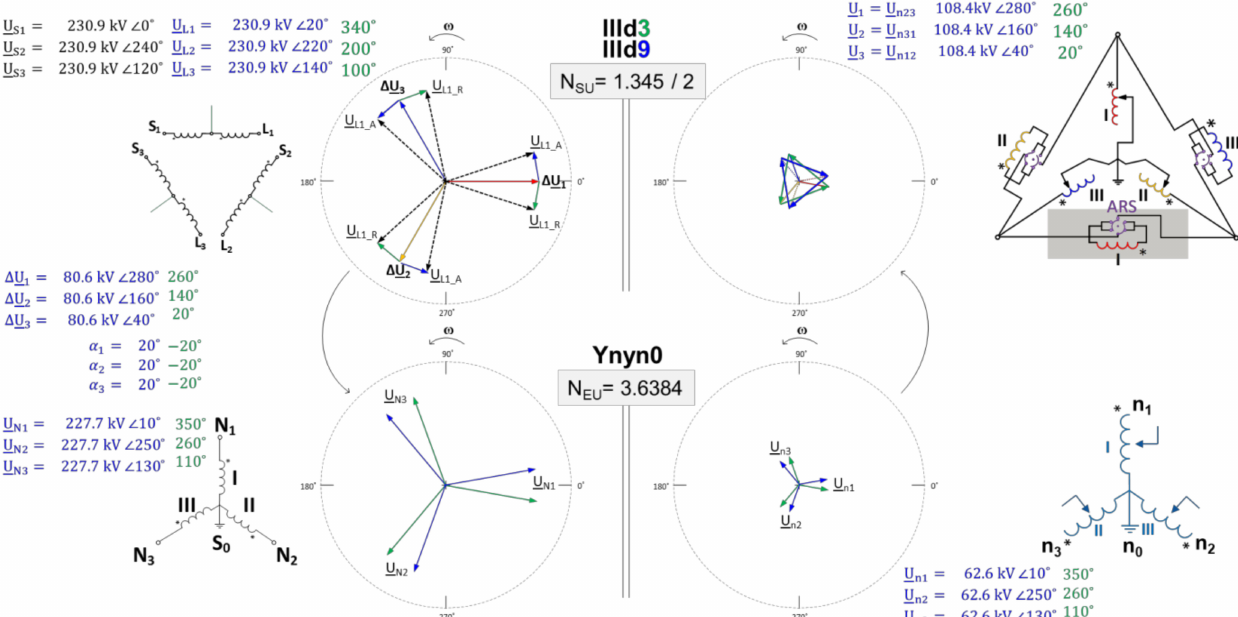
Figure 5. Voltage vector diagram for individual PST transformer units based on symmetrical, dual-tank solution with rated voltage of 400 kV and maximum phase shift adjustment ( ± 20 ◦